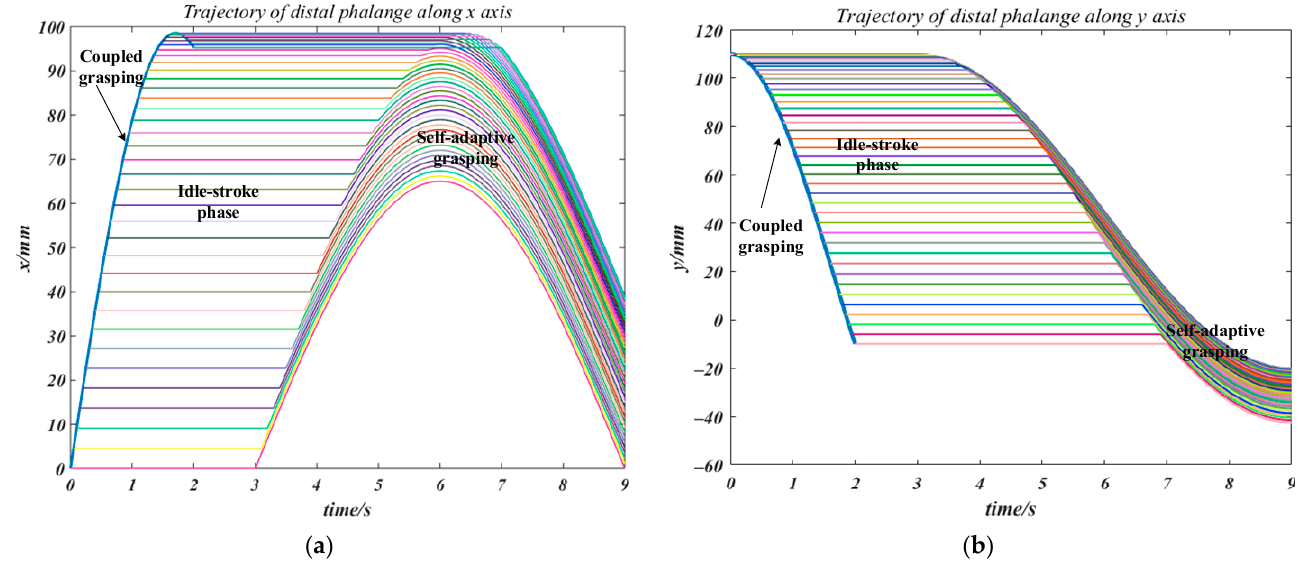
Figure 11. Kinematic analysis of the ESMGM hand (COSA mode): ( a ) Trajectory along the x ‐ axis; ( b ) trajectory along the y ‐ axis.